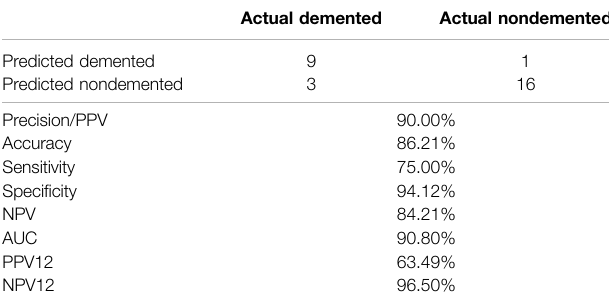
TABLE 2 | Performance for testing set after hyperparameter